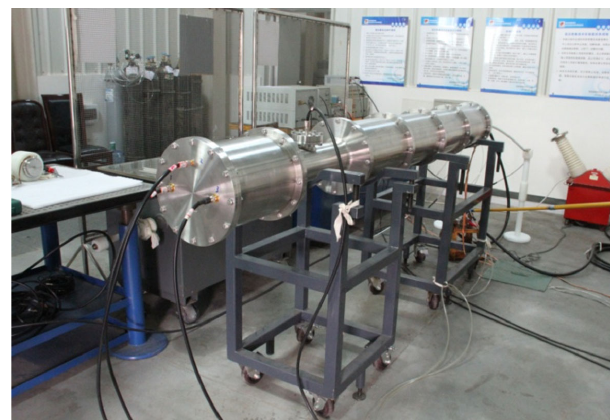
FIG. 11. Picture of the four-stage coaxial Marx.